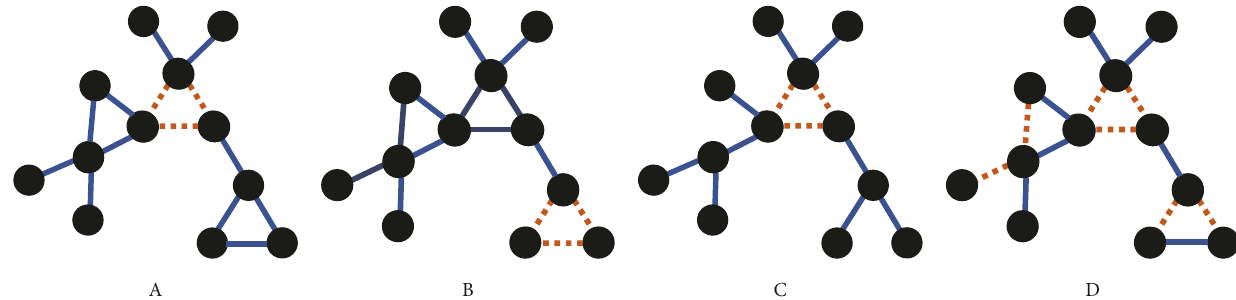
Figure 9: Four networks with 12 nodes and one negative triad (NNN). Networks A, B, and C have only three negative edges, while D has the same structure and density (number of edges) as A and B, but more negative